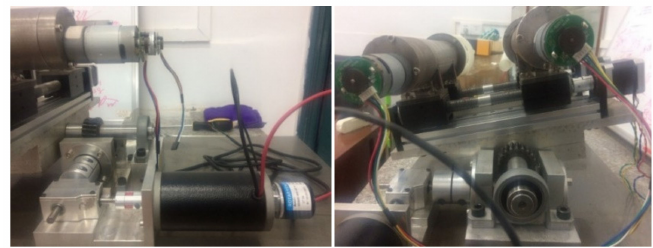
Figure 7. Amplitude changing device display.